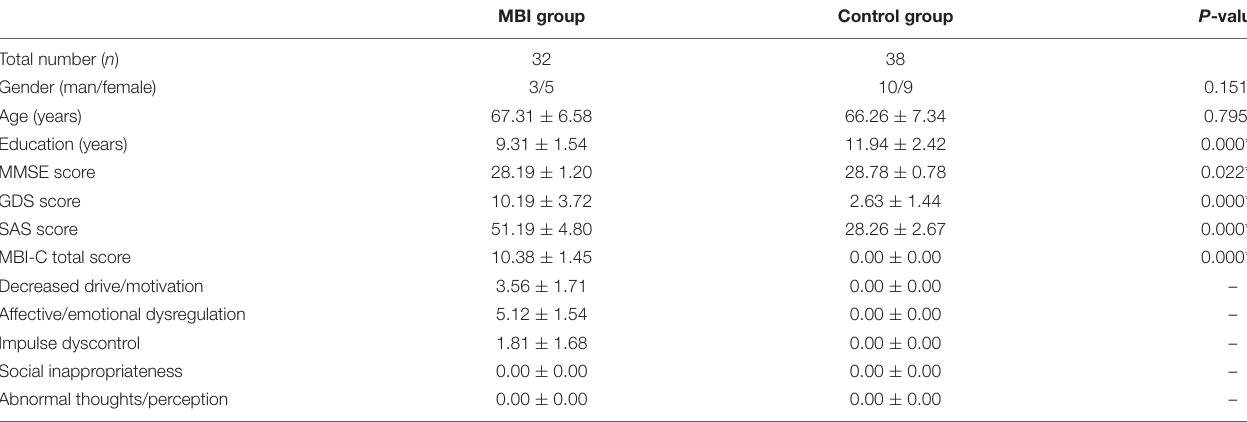
TABLE 1 | Demographic data of the